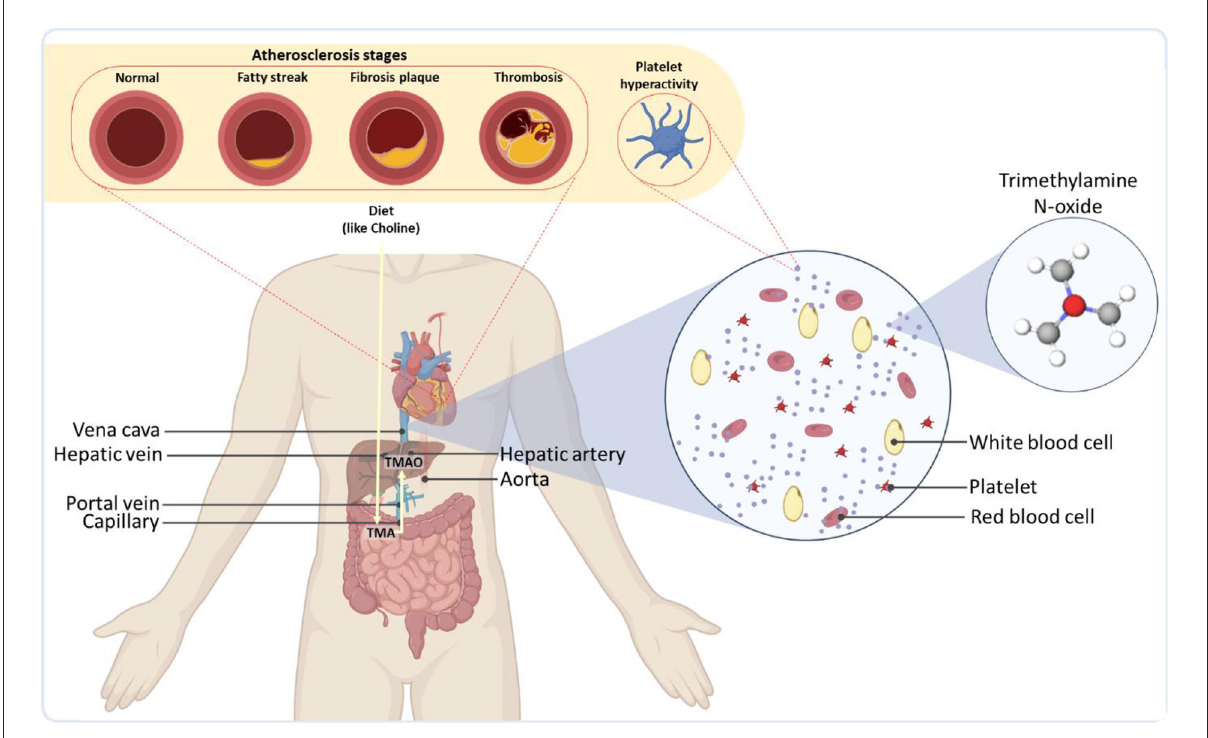
FIGURE1 Overall representation of gut microbiota as a regulator of the cardiovascular systems of the body. As an example, TMA produced by the microbiome is transported to the liver through the portal vein and readily metabolized by host hepatic flavin monooxygenases into trimethylamine-N-oxide (TMAO). TMAO is then released into the bloodstream, leading to severe cardiovascular